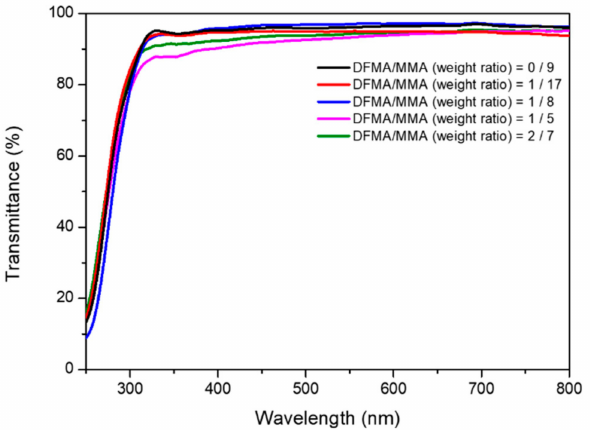
Figure 10. The UV–vis analysis of the polyacrylate coating films prepared from different weight ratios of